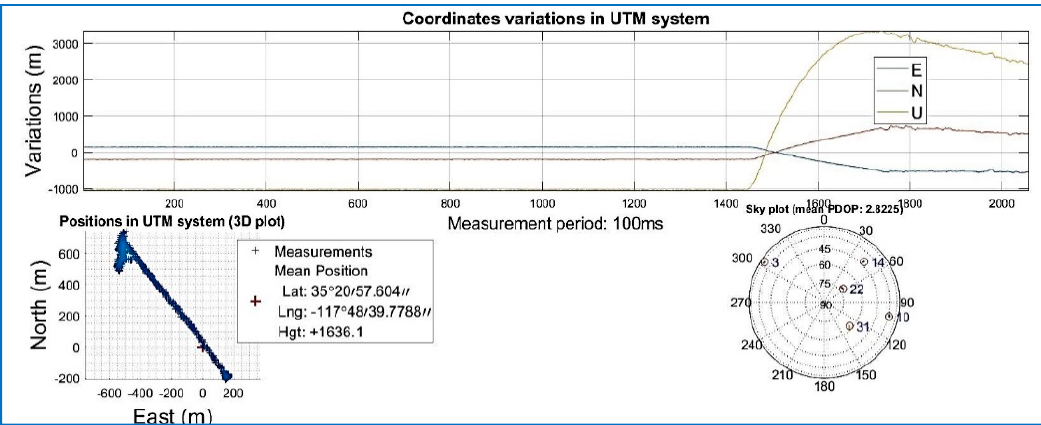
Figure 16. Navigation solution of Dataset 3 (not compressed). Sensors 2018 , 18 , x FOR PEER REVIEW